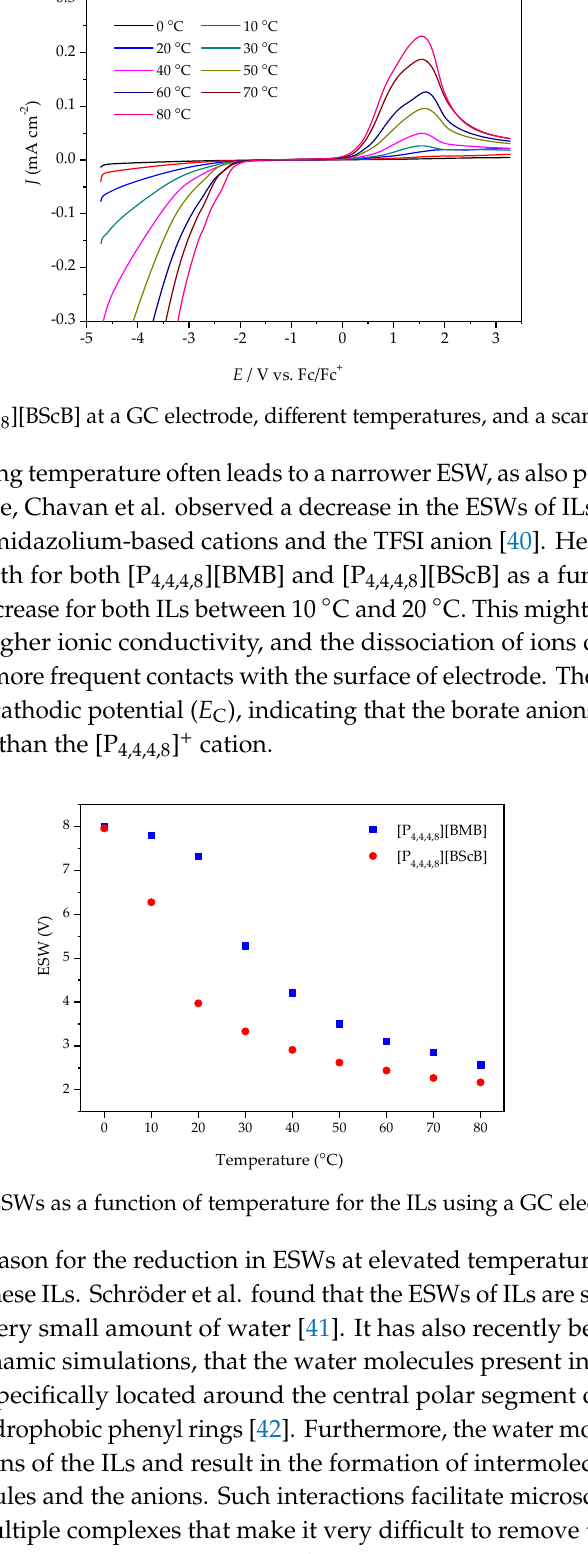
Figure 7. ESWs as a function of temperature for the ILs using a GC electrode.